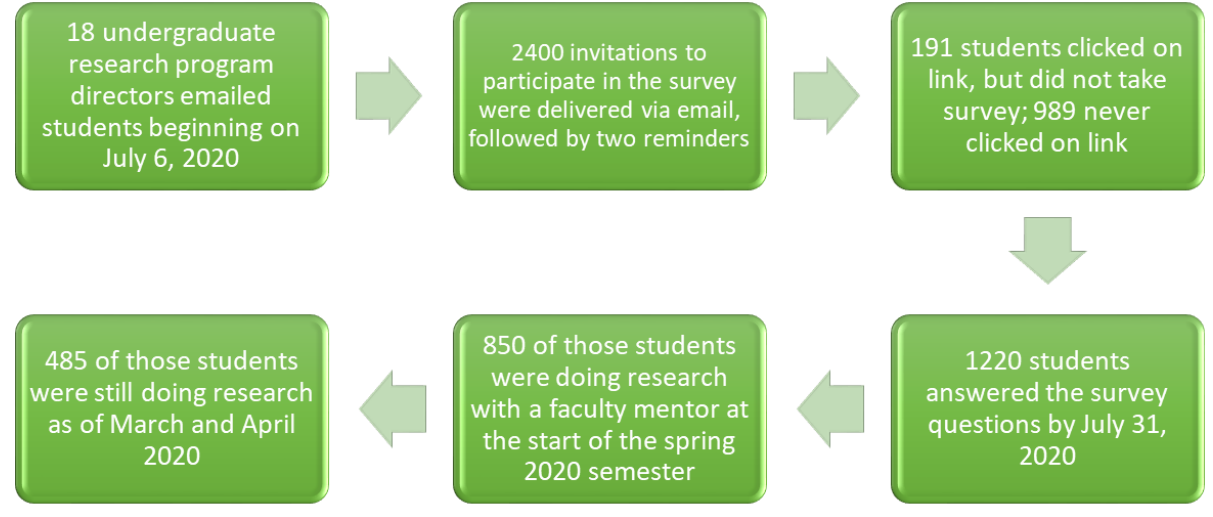
Figure 2. Diagram of the data collection process, including inclusion criteria for this analysis.